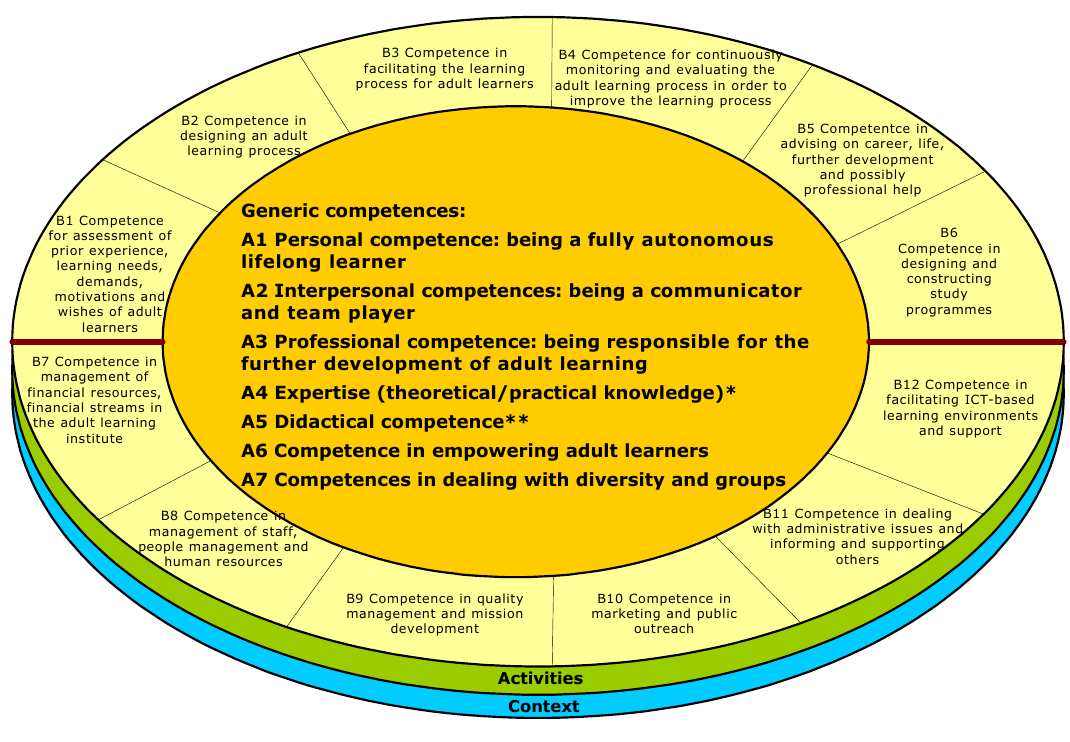
Figure 1. Set of key competencies of adult learning